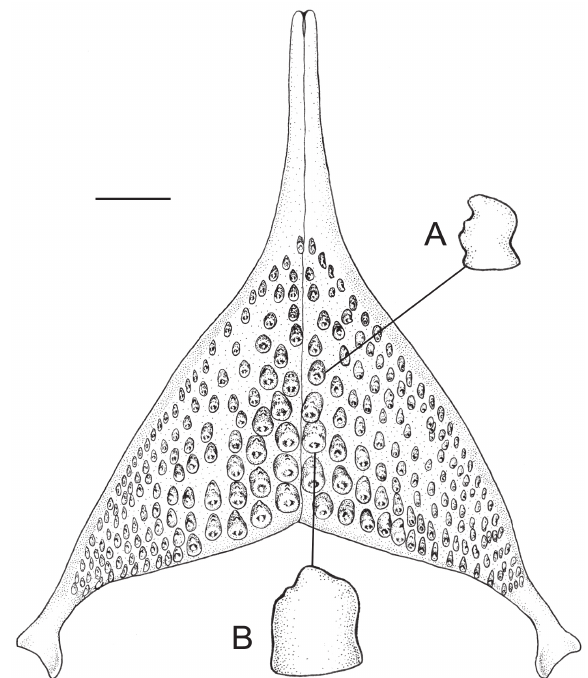
Fig. 4. Geophagus mirabilis , NUP 15117, 107.8 mm SL, Brazil, State of Mato Grosso, município de Juína, rio Aripuanã, upstream from Dardanelos/Andorinhas falls. Lower pharyngeal jaw in occlusal aspect, anterior portion upwards. (A) and (B), lateral view of two different teeth, proportionally enlarged, anterior portion to left side. Scale bar = 1 mm, not applied to (A) and